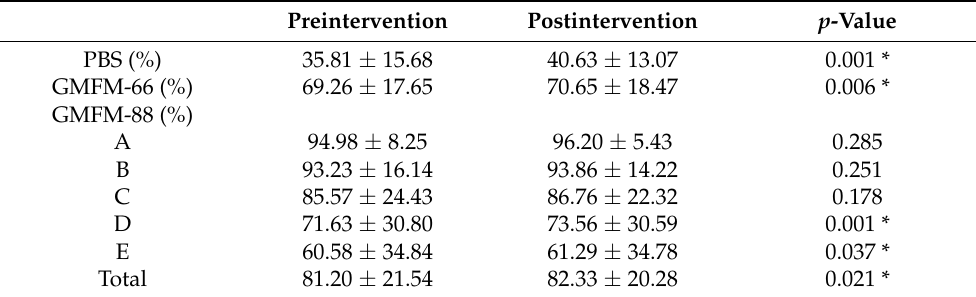
Table 2. Changes in Pediatric Balance Scale and Gross Motor Function Measure